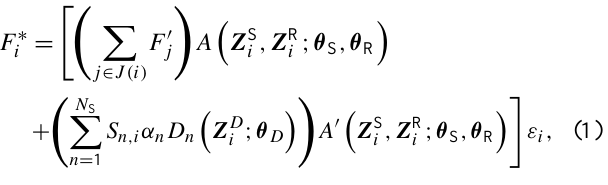
snowmelt season of mid-March to May and heavy rainfalls in May–late November. In this basin, the regional average